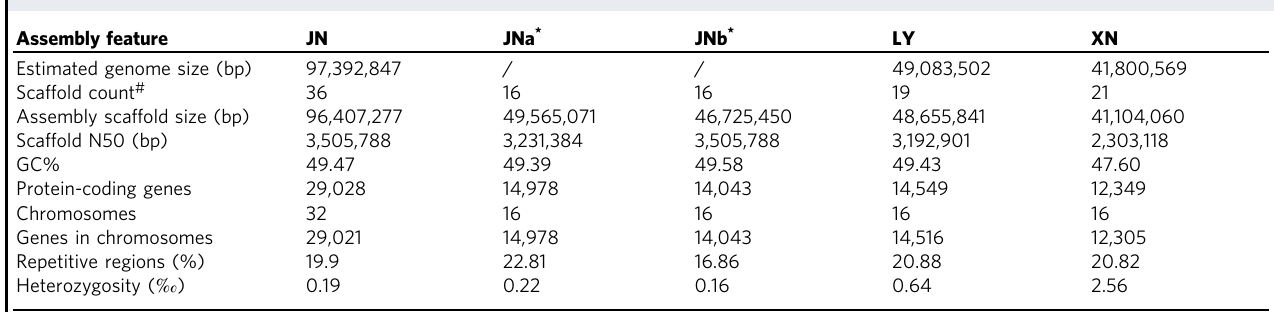
Table 1 Description of Rhizoctonia spp. genome